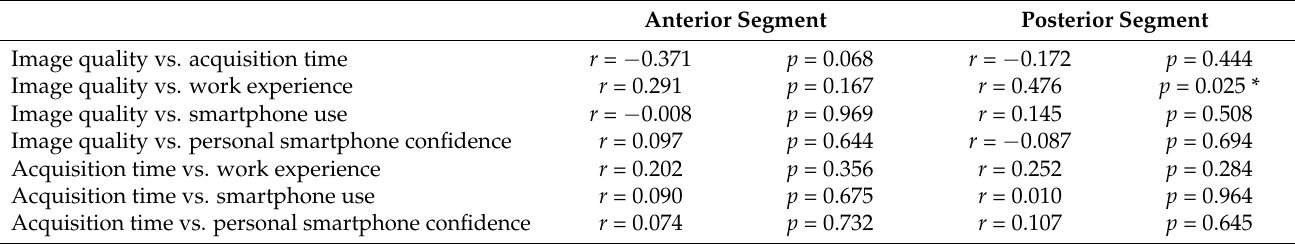
Table 5. Correlations in the smartphone